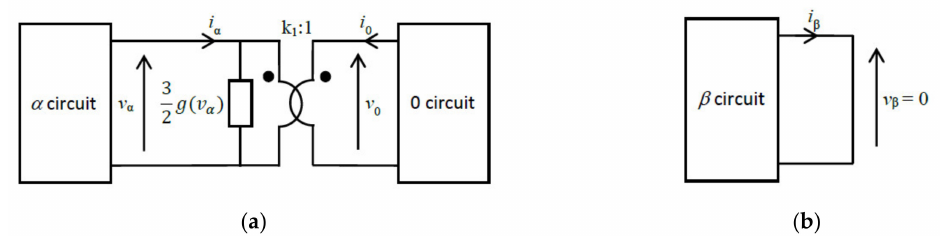
√ 2, and ( b ) an uncoupled and